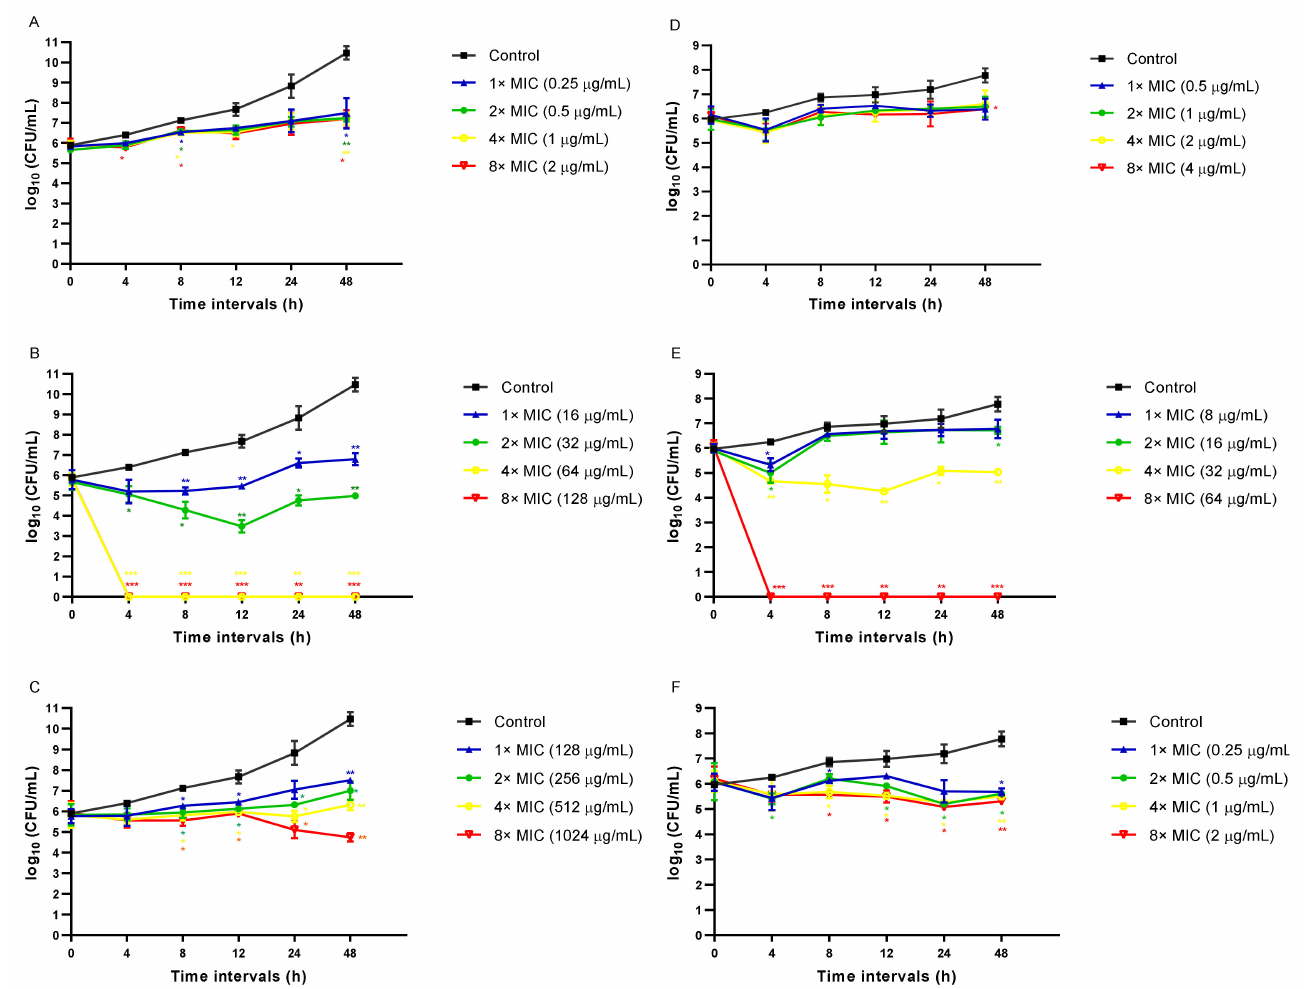
Figure 1. Time-kill curves obtained by incubating C. auris CAU-04 ( A – C ) and C. albicans SC5314 ( D – F ) strains with increasing concentrations of EA ( A , D ), CAPE ( B , E ) and FLC ( C , F ). Data represent the mean ( ± standard deviation, SD) of three independent experiments, and each one was carried out with triplicate determinations. For all experimental points, * p < 0.05, ** p < 0.01 or *** p < 0.001 were obtained for control versus treated